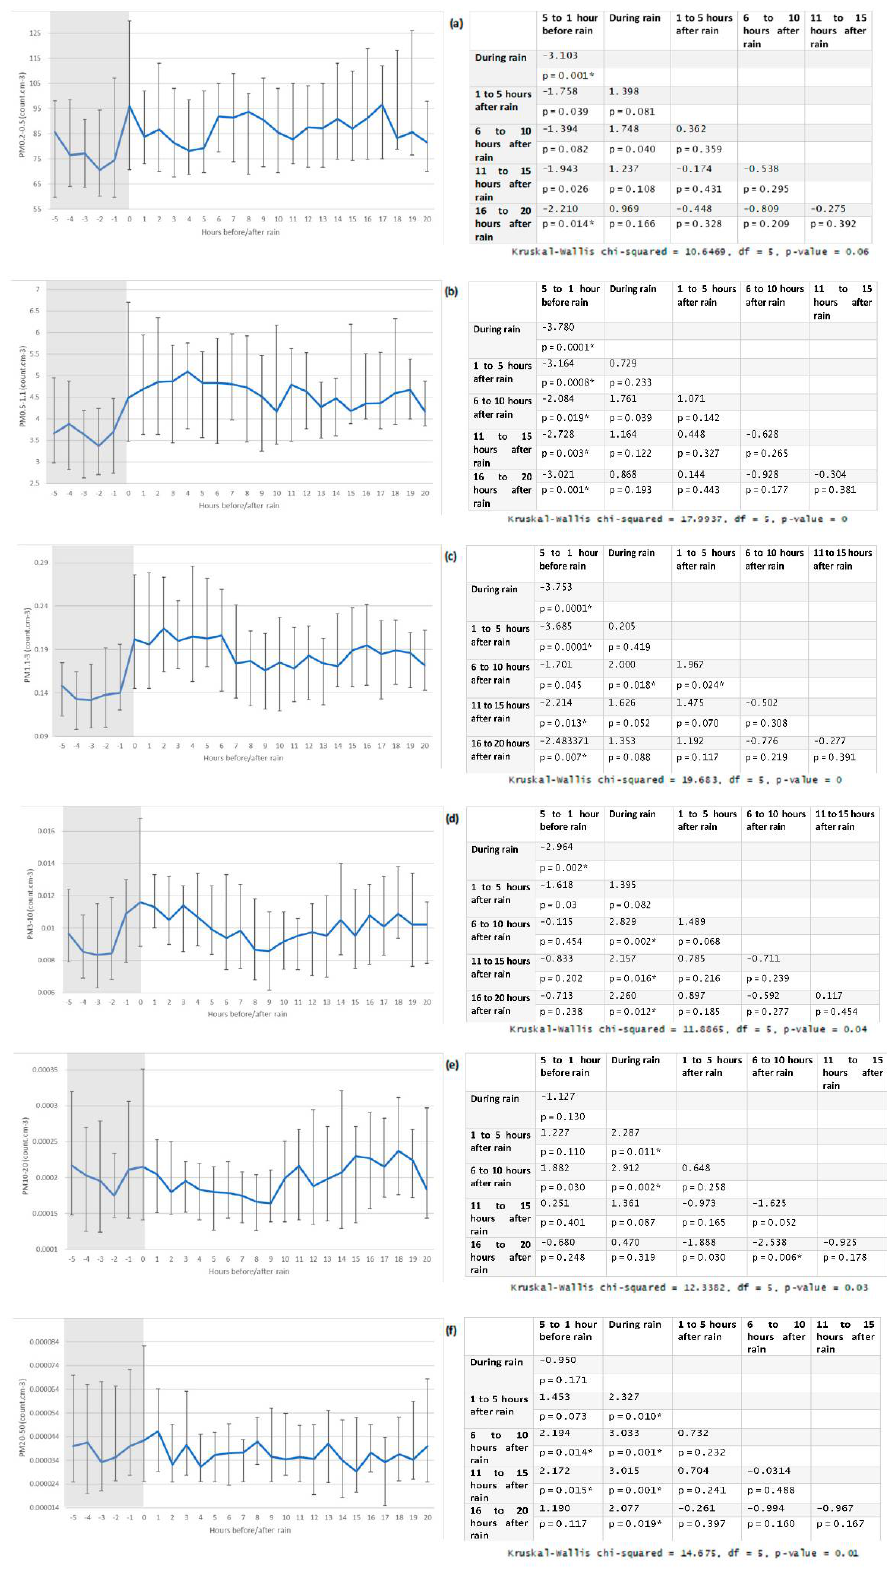
Figure 7. Median, 40th and 60th percentile PM concentrations by hour before and after rain for 154 rain events and corresponding Dunn’s test result tables for size ranges: ( a ) 0.2–0.5 µm; ( b ) 0.5–1.1 µm; ( c ) 1.1–3 µm; ( d ) 3–10 µm; ( e ) 10–20 µm and ( f ) 20–50 µm for the three locations between 2013 and 2019 (* indicates statistical significance).